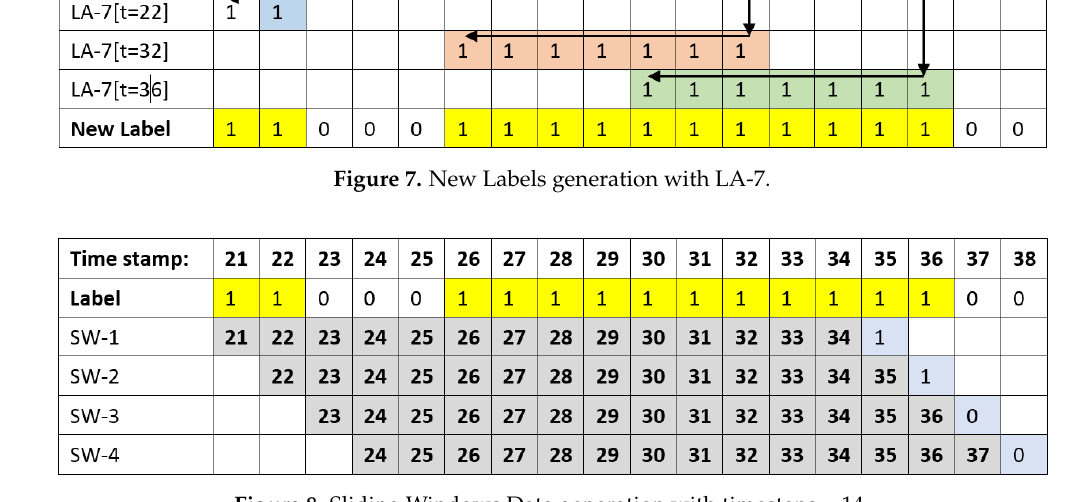
Figure 8. Sliding Windows Data generation with timesteps =